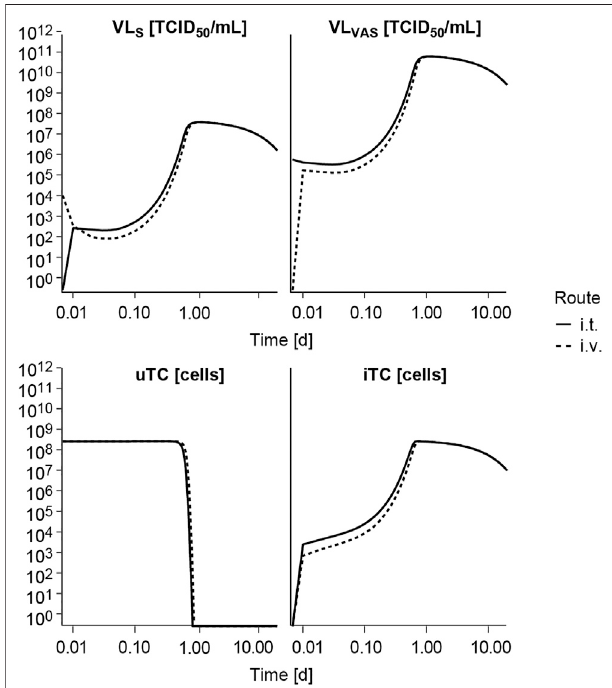
FIGURE 4 | Model exploration. Model predicted time course of the different entities following intravenous (i.v.) or intratumoral (i.t.) single administration of V937 at a dose levels of 10 4 TCID 50 . VL S , viral load in serum; VL VAS , viral load in tumor vasculature; uTC, uninfected tumor cells; iTC, infected tumor cells. Log-log scale used.